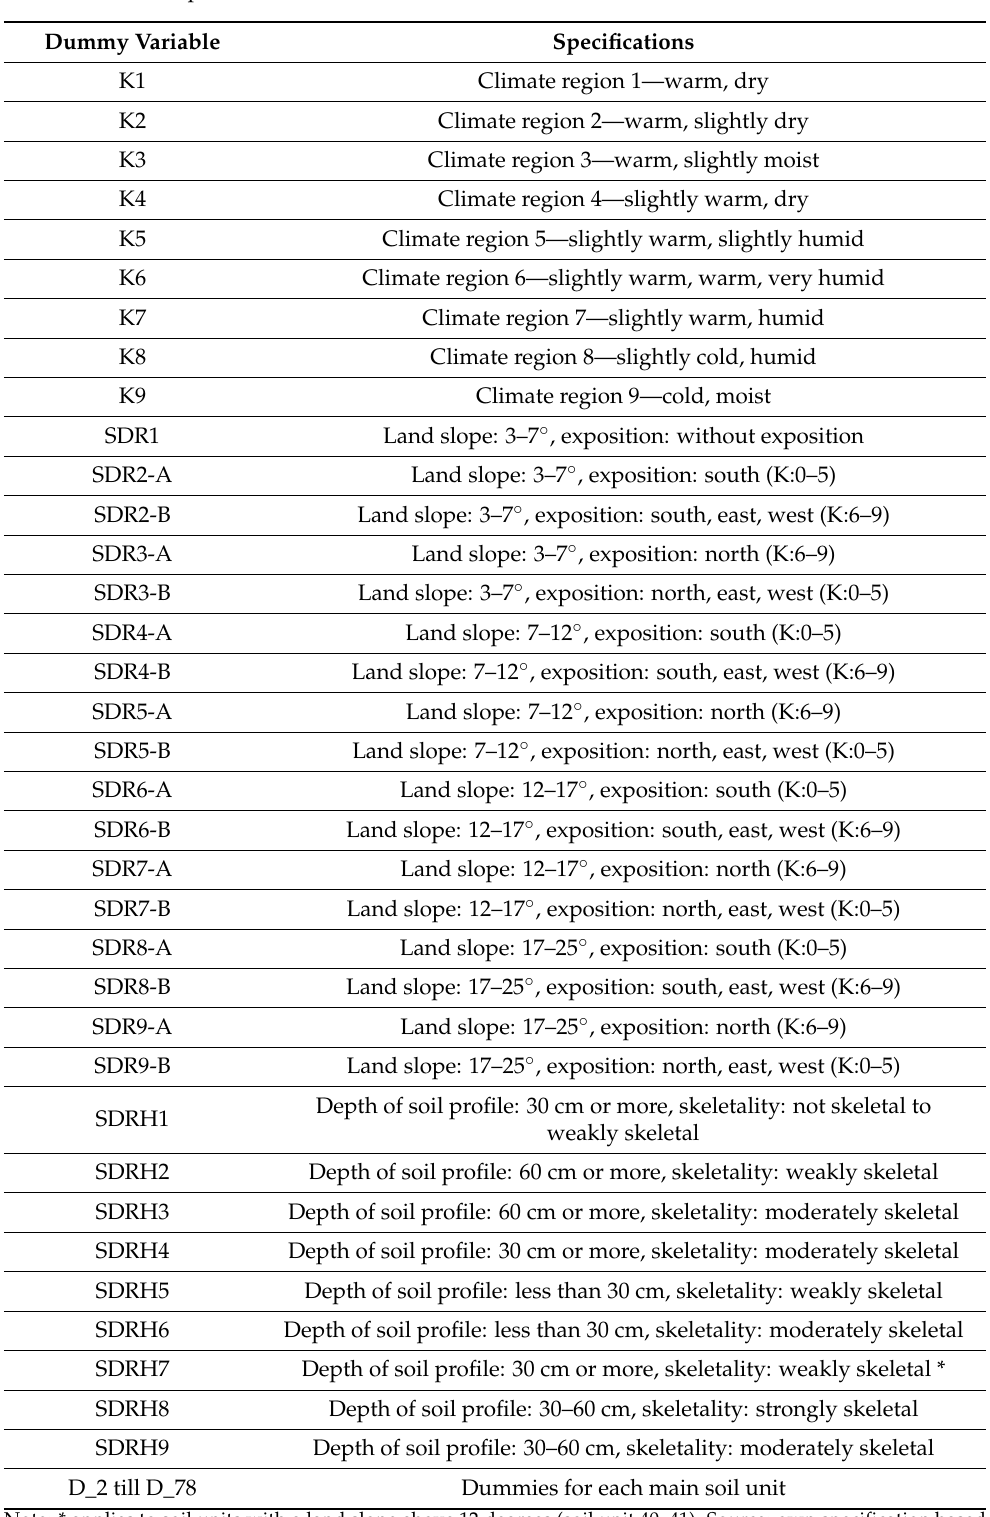
Table 1. Detailed specifications of the variables in the